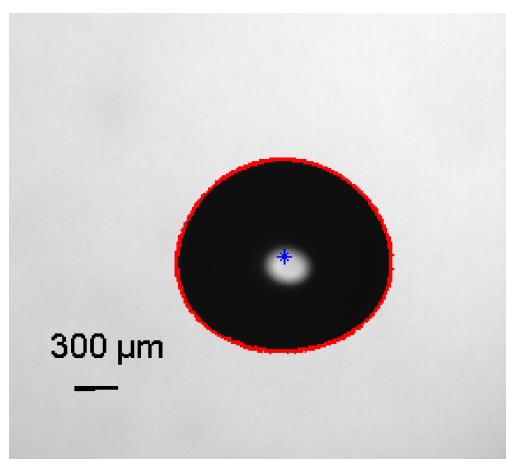
Figure 3. Example of a shadow image.